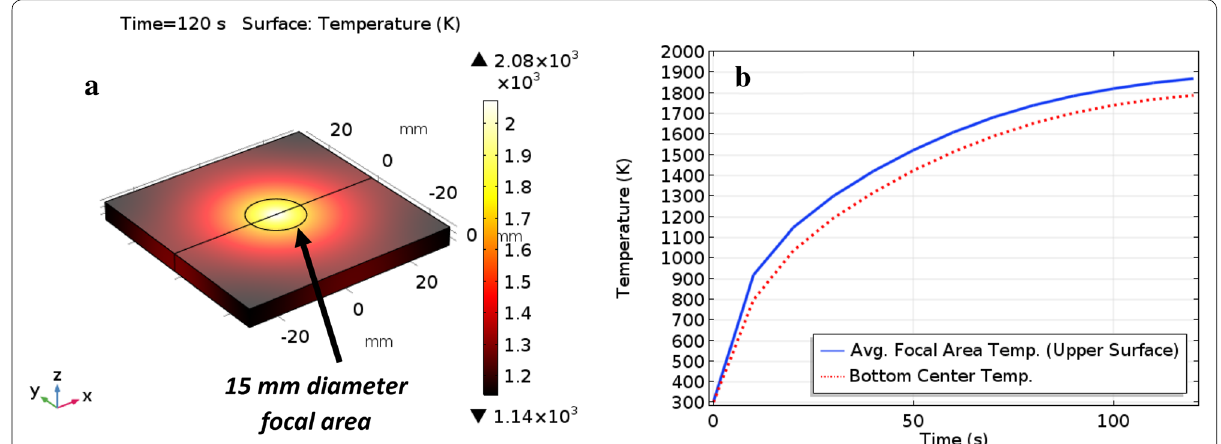
Fig. 7 Solar welding ray-heating simulation. a Receiver (Welded H13 steel sheets) temperature map at 120 s. b Average focal area temperature change with time, and lower central point temperature change with